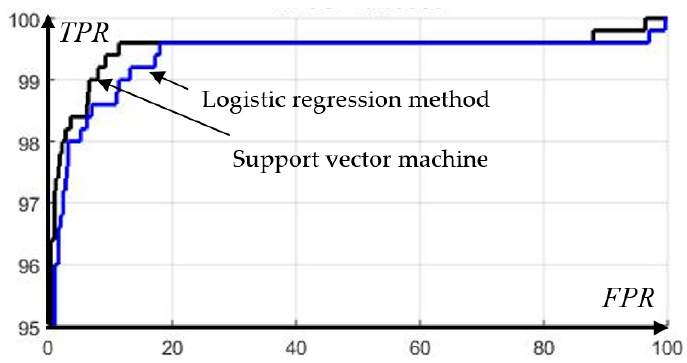
Figure 13. Comparison of receiver performance corresponding to logistic regression and support vector methods.